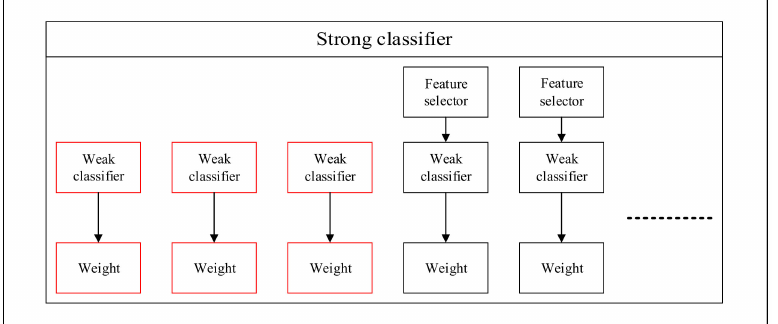
Figure 18. Selection of a suitable weak classifier again from the feature